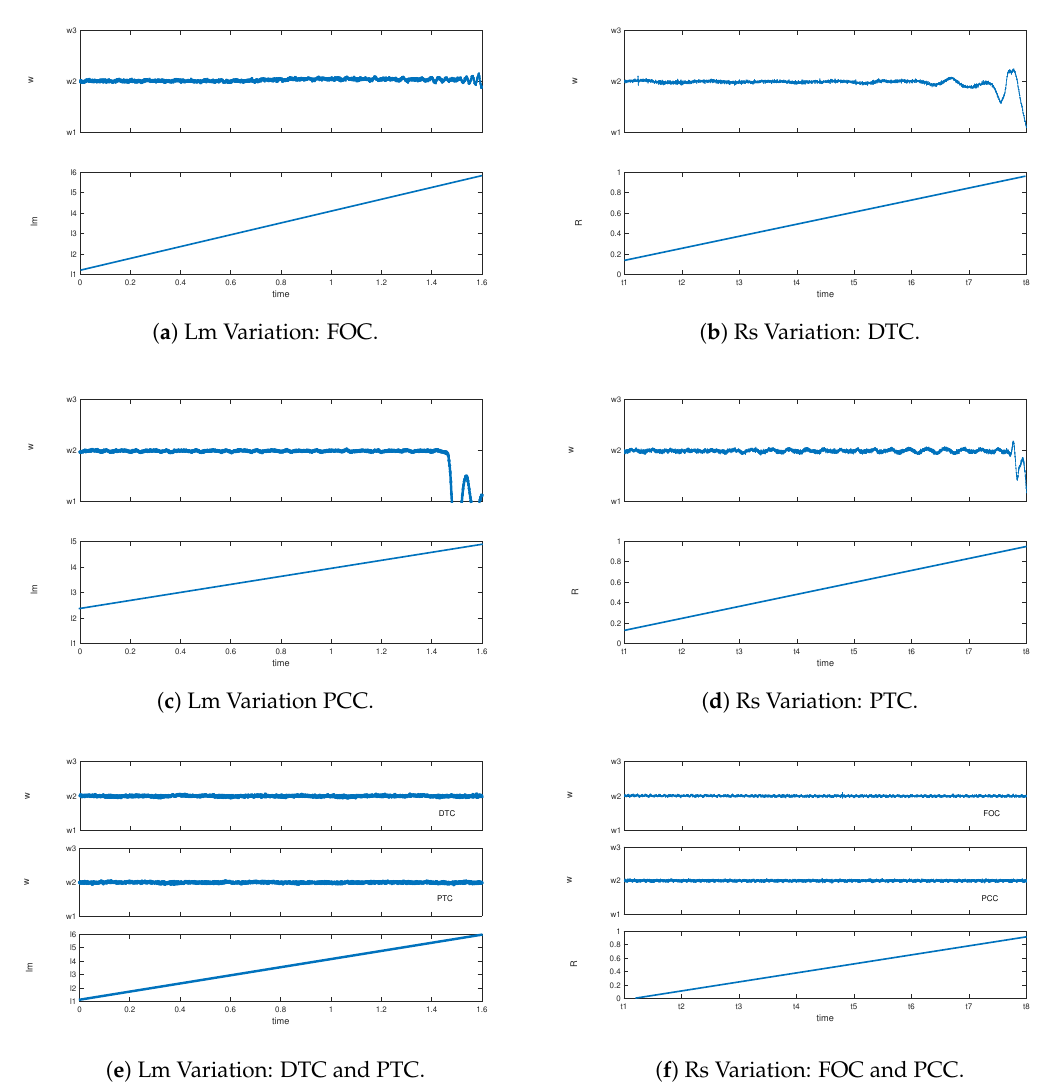
( f ) Rs Variation: FOC and PCC. Figure 6. Experimental results: sensitivities of Rs and Lm at speed of 100 rpm without